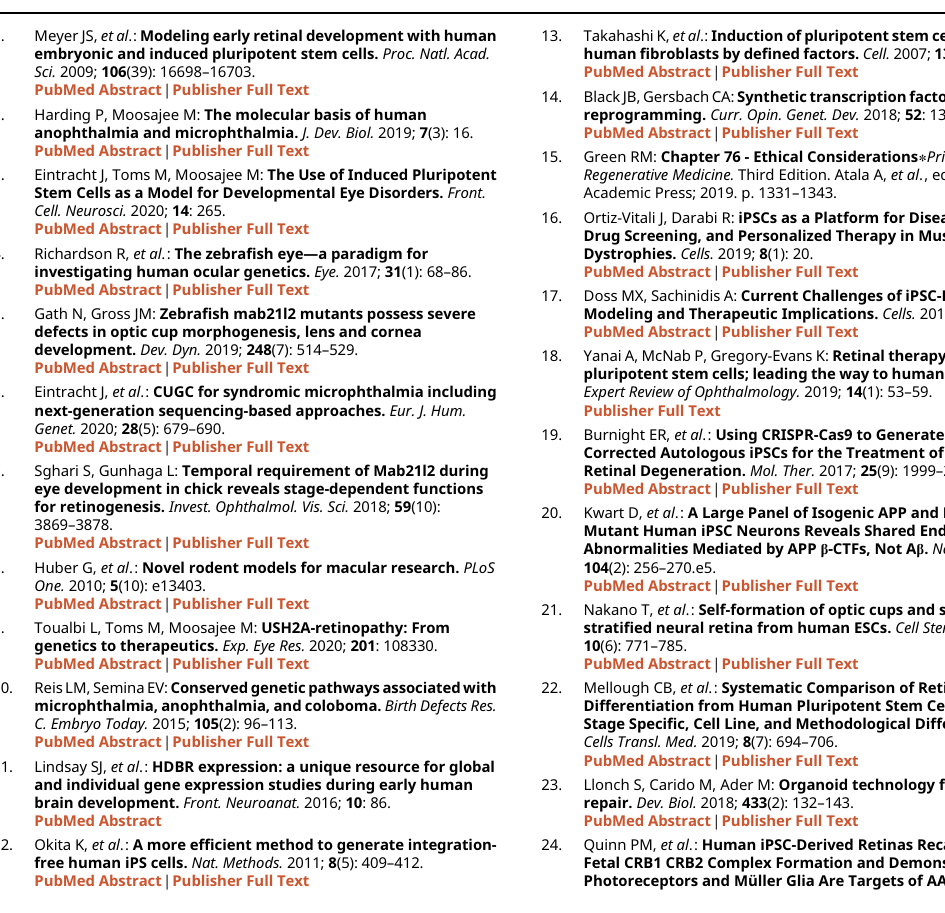
‐ Figure 6a PAX6 CRX panel - C1-MAX_04.05.21_WT1_D50.1_190421_DAPI_630x_crop.jpg ‐ Figure 6a PAX6 CRX panel - C2-MAX_04.05.21_WT1_D50.1_190421_PAX6_630x_crop.jpg ‐ Figure 6a PAX6 CRX panel - C3-MAX_04.05.21_WT1_D50.1_190421_CRX_630x_crop.jpg ‐ Figure 6b BRN3b VSX2 panel - C1-MAX_04.05.21_WT1_D50.1_190421_DAPI_630x_crop.jpg ‐ Figure 6b BRN3b VSX2 panel - C2-MAX_04.05.21_WT1_D50.1_190421_VSX2_630x_crop.jpg ‐ Figure 6b BRN3b VSX2 panel - C3-MAX_04.05.21_WT1_D50.1_190421_BRN3_630x_crop.jpg ‐ Figure 6c Recoverin OTX2 panel - C1-MAX_04.05.21_WT1_D50.1_190421_DAPI_630x_2_crop.jpg ‐ Figure 6c Recoverin OTX2 panel - C2-MAX_04.05.21_WT1_D50.1_190421_RCVN_630x_2_crop.jpg ‐ Figure 6c Recoverin OTX2 panel -